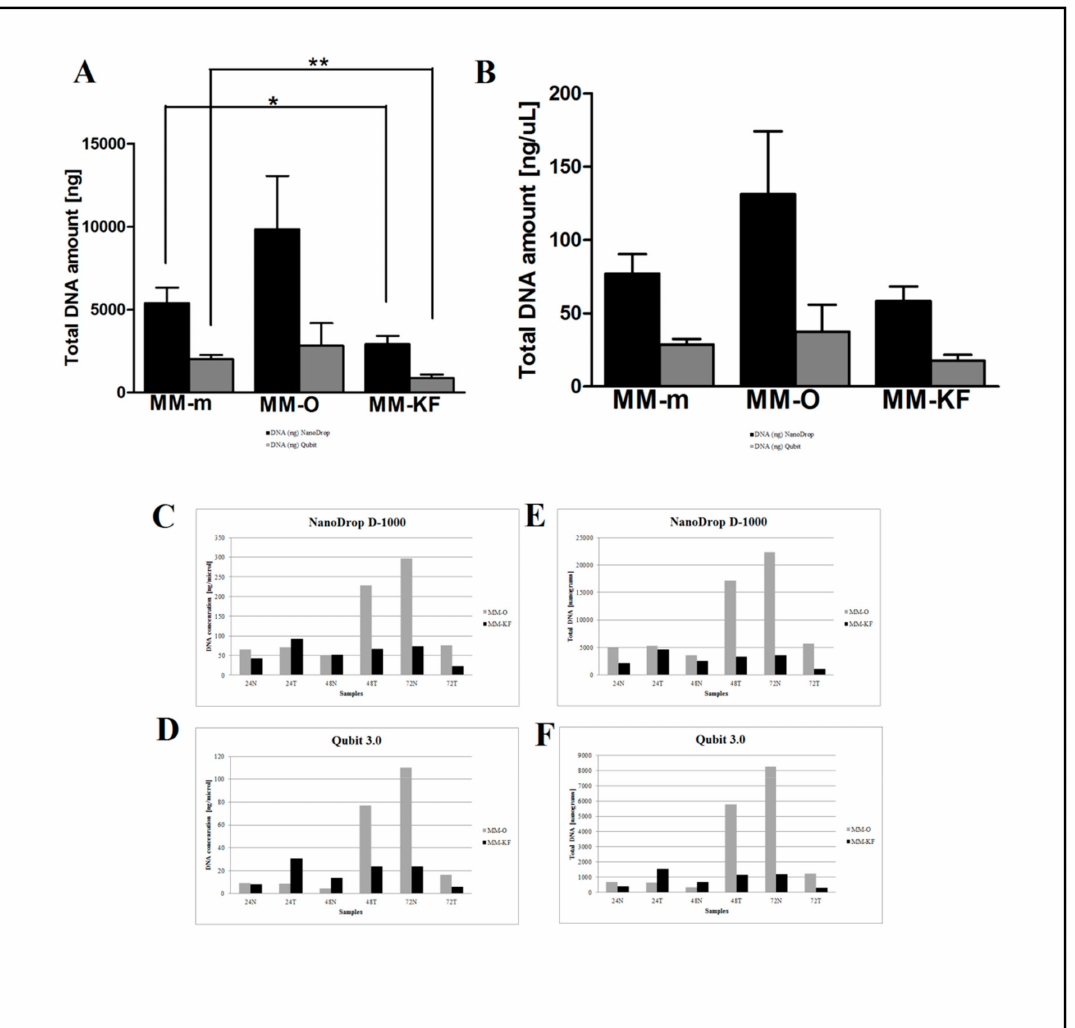
Figure 3. Comparison of two automatic DNA extraction systems (OMNIA Prima and King Fisher